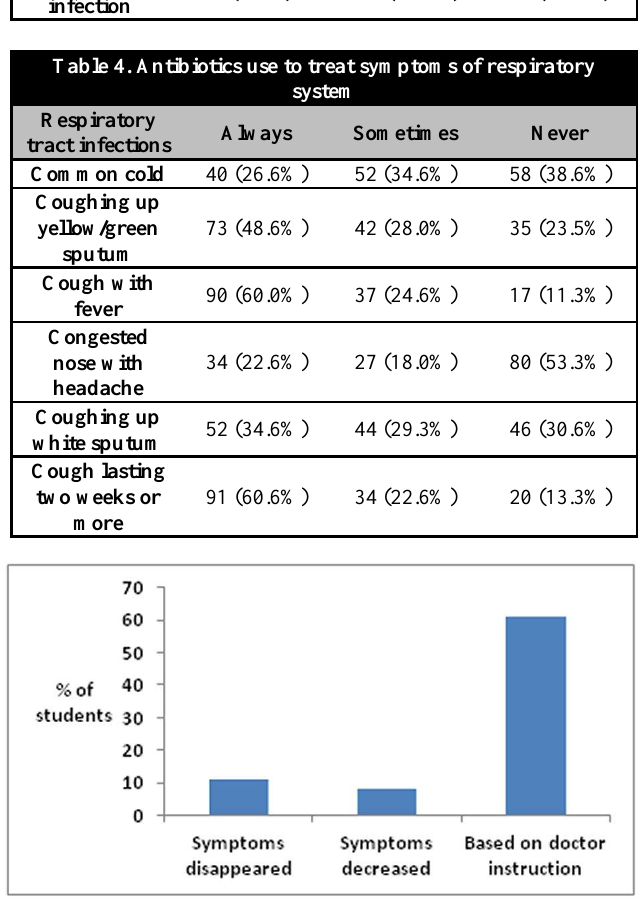
Figure 1: Time stopping